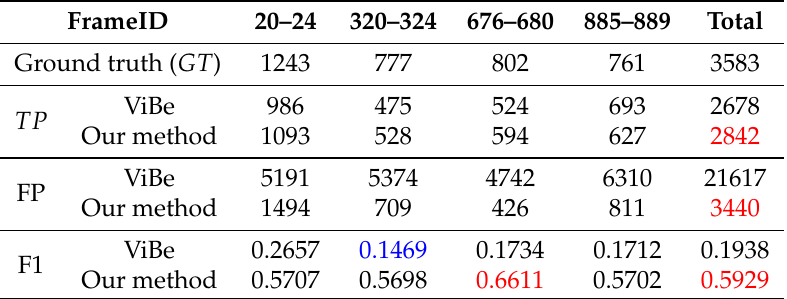
Table 1. The detection result of our method and original ViBe (Visual Background extractor) on different